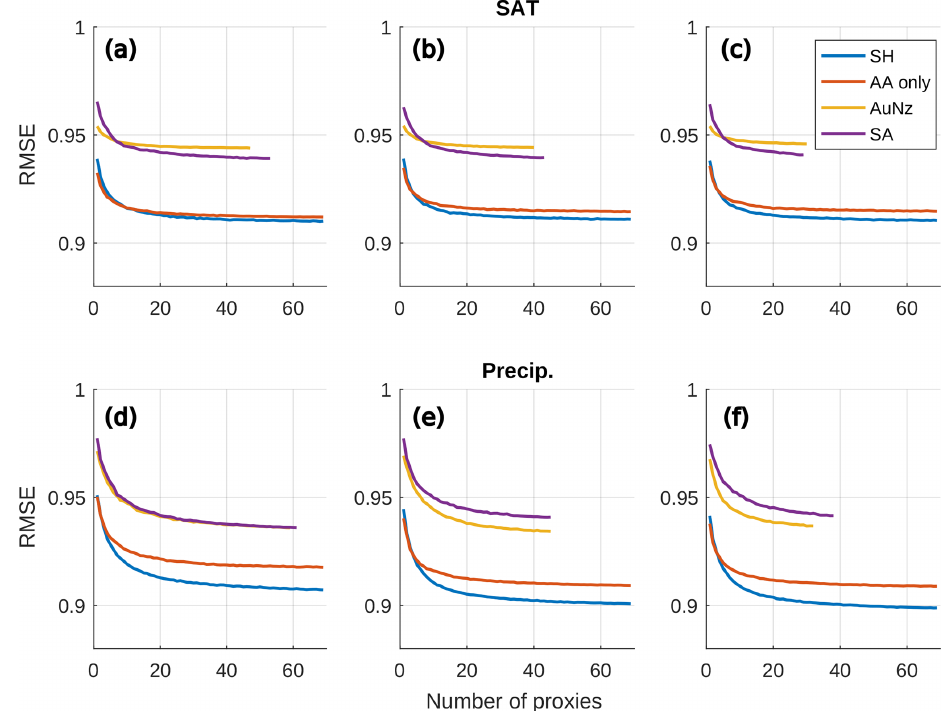
Figure A2. Median root mean square error across the 10000 reconstructions calculated for each network size for SAT-derived (a, b, c) and precipitation-derived (d, e, f) reconstructions. Results are displayed for the 31 year (a, d) , 61 year (b, e) , and 91 year (c, f) calibration windows. Data is displayed for reconstructions derived from the entire southern hemisphere (SH – blue line), Antarctica only (AA only – red line), Australia and New Zealand (AuNZ – yellow line), and South America (SA – purple line).